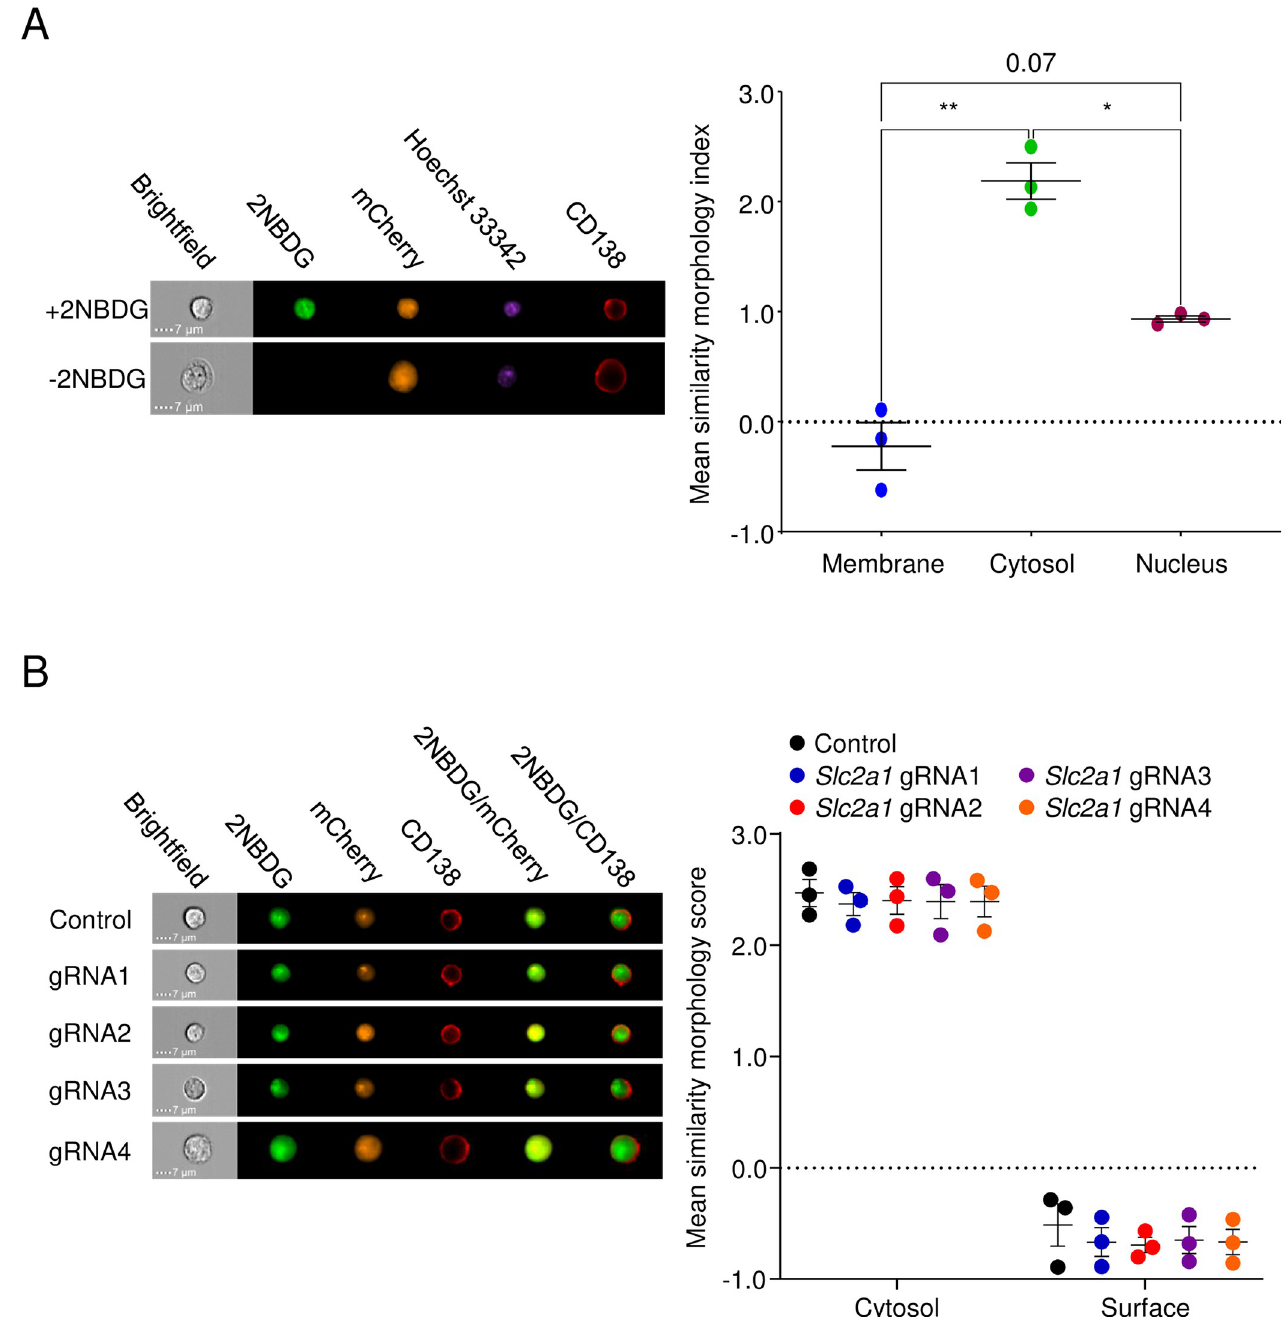
Fig 2. Plasma cells take up 2NBDG and retain it in the cytosol. (A) 2NBDG is retained in the cytosol of cells. 5TGM1 cells previously transduced with a Cas9-T2A-mCherry lentivirus were treated with 2NBDG, stained for surface CD138 and Hoeschst 33342, and analyzed by imaging flow cytometry. Representative images of cells treated with 2NBDG (top left) relative to untreated cells (bottom left) at 60x magnification are shown. Mean similarity morphology indices for 2NBDG and other stains/dyes were quantified and shown (right). (B) Cas9-mCherry expressing 5TGM1 cells were transduced with control gRNA or Slc2a1 gRNA lentiviruses. Representative images of each gRNA group (left) at 60x magnification are shown with overlays for 2NBDG/CD138 and 2NBDG/mCherry. Mean similarity morphology indices were quantified (right). For both panels, each dot indicates the mean value for a group in a single experiment. No significant differences were observed with ordinary two-way ANOVA with Dunnett’s multiple comparison test.